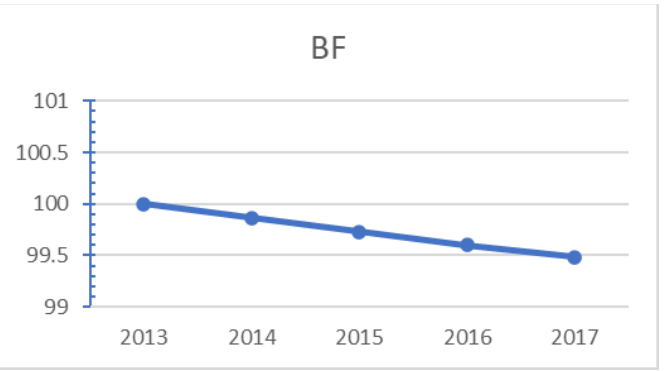
Figure 18. Biocapacity trend from 2013 to 2017. Percentage values refer to